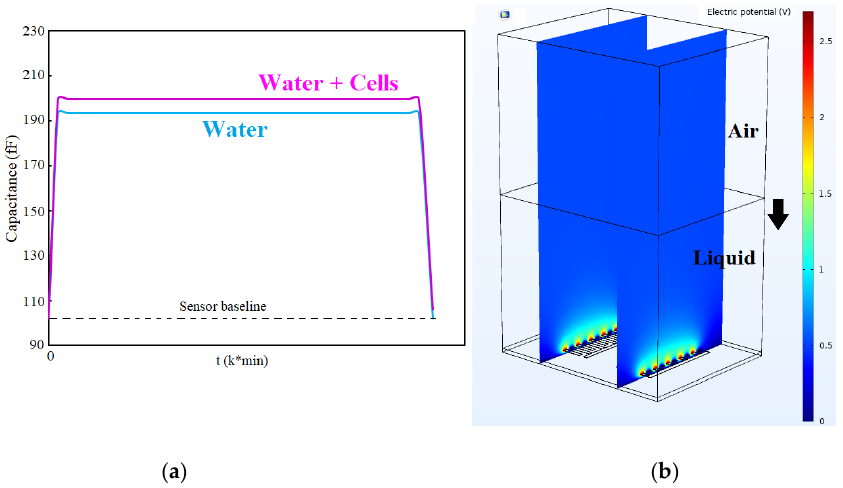
Figure 6. ( a , b ) COMSOL simulation showing the saturation of the sensor in liquids and returning to baseline.